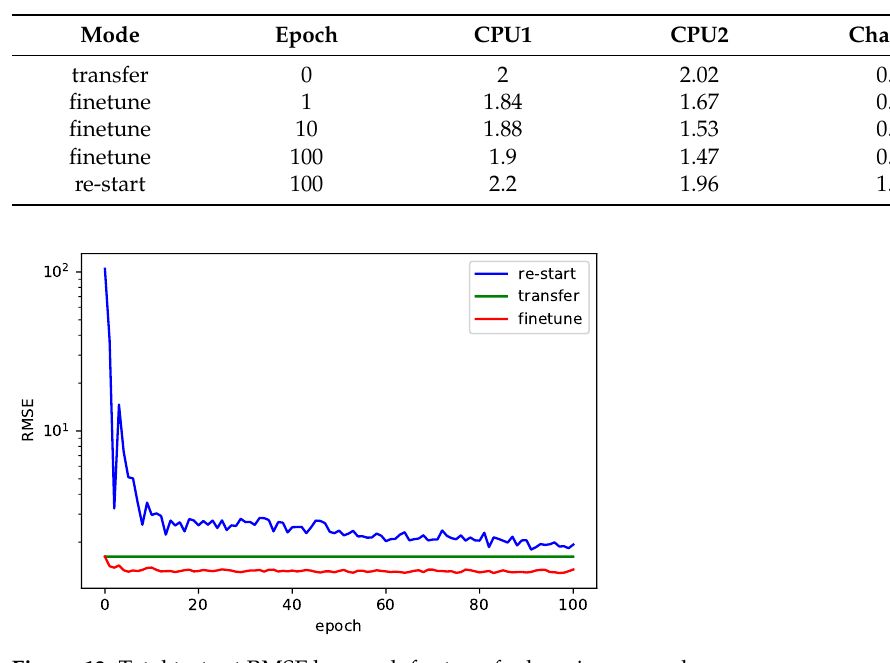
Figure 13. Total test set RMSE by epoch for transfer learning